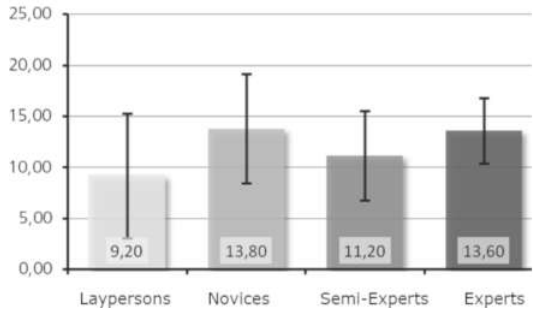
Figure 7. Number of fixated basic features (Daphne).